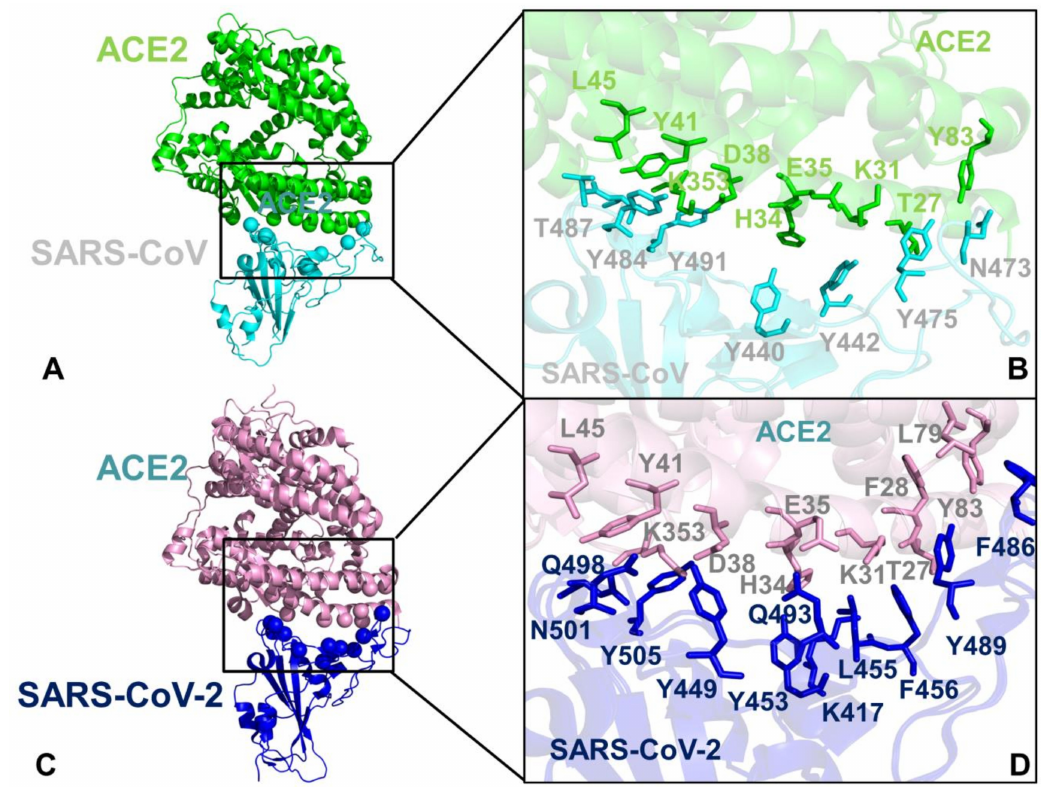
Figure 11. Structural mapping of the binding energy hotspots in the SARS-CoV-RBD and SARS-Cov-2-RBD complexes with ACE2. ( A ) A general overview of the SARS-CoV-RBD complex with ACE2. SARS-CoV-RBD is shown in cyan ribbons and ACE2 is in green ribbons. The binding energy hotspots that experience significant loss of binding energy upon alanine mutations are shown in cyan spheres for SARS-CoV-RBD and in green spheres for ACE2. ( B ) A close-up of these binding energy hotspots in the SARS-CoV-RBD complex with ACE2. The SARS-CoV-RBD residues are annotated and shown in cyan sticks, ACE2 hotspot residues are in green sticks. ( C ) A general overview of the SARS-CoV-2-RBD complex with ACE2. SARS-Cov-2-RBD is shown in blue ribbons and ACE2 is in pink ribbons. The binding energy hotspots that experience significant loss of binding energy upon alanine mutations are shown in blue spheres for SARS-CoV-2-RBD and in pink spheres for ACE2. ( D ) A close-up of the binding energy hotspots in the SARS-CoV-2-RBD complex with ACE2. The SARS-CoV-RBD residues are annotated and shown in blue sticks, ACE2 hotspot residues are in pink